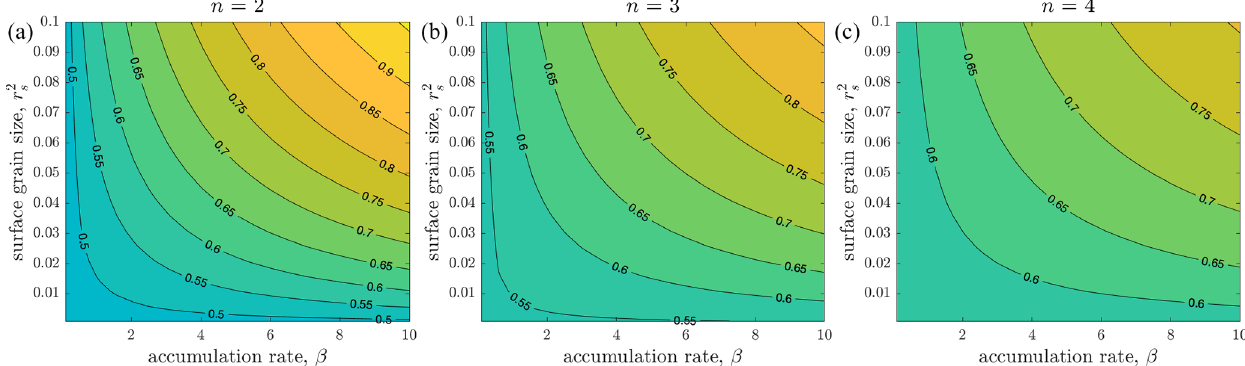
Figure 7. Firn thickness z 830 as a function of surface grain-size r 2 s and accumulation rate β using the full model with (a) n = 2, (b) n = 3, and (c) n = 4 and corresponding values of α (cid:48) . All other parameters are the same as used for the simulations plotted in Fig. 6. The colour scales are the same as used in Fig.